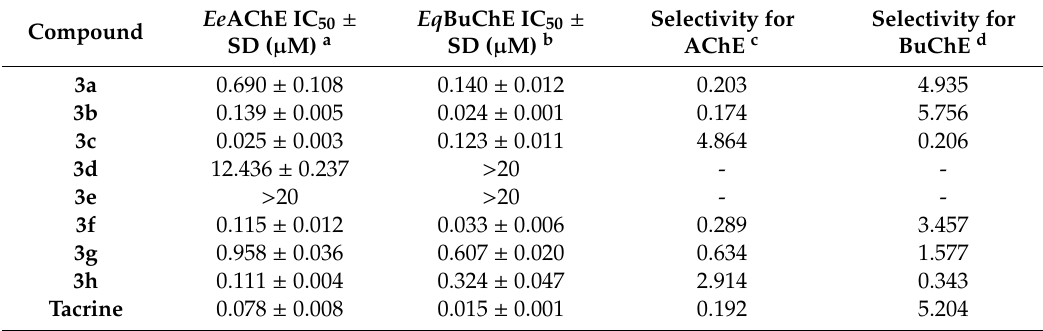
Table 1. Cholinesterase inhibitory activities of the synthesized compounds 3a – 3h